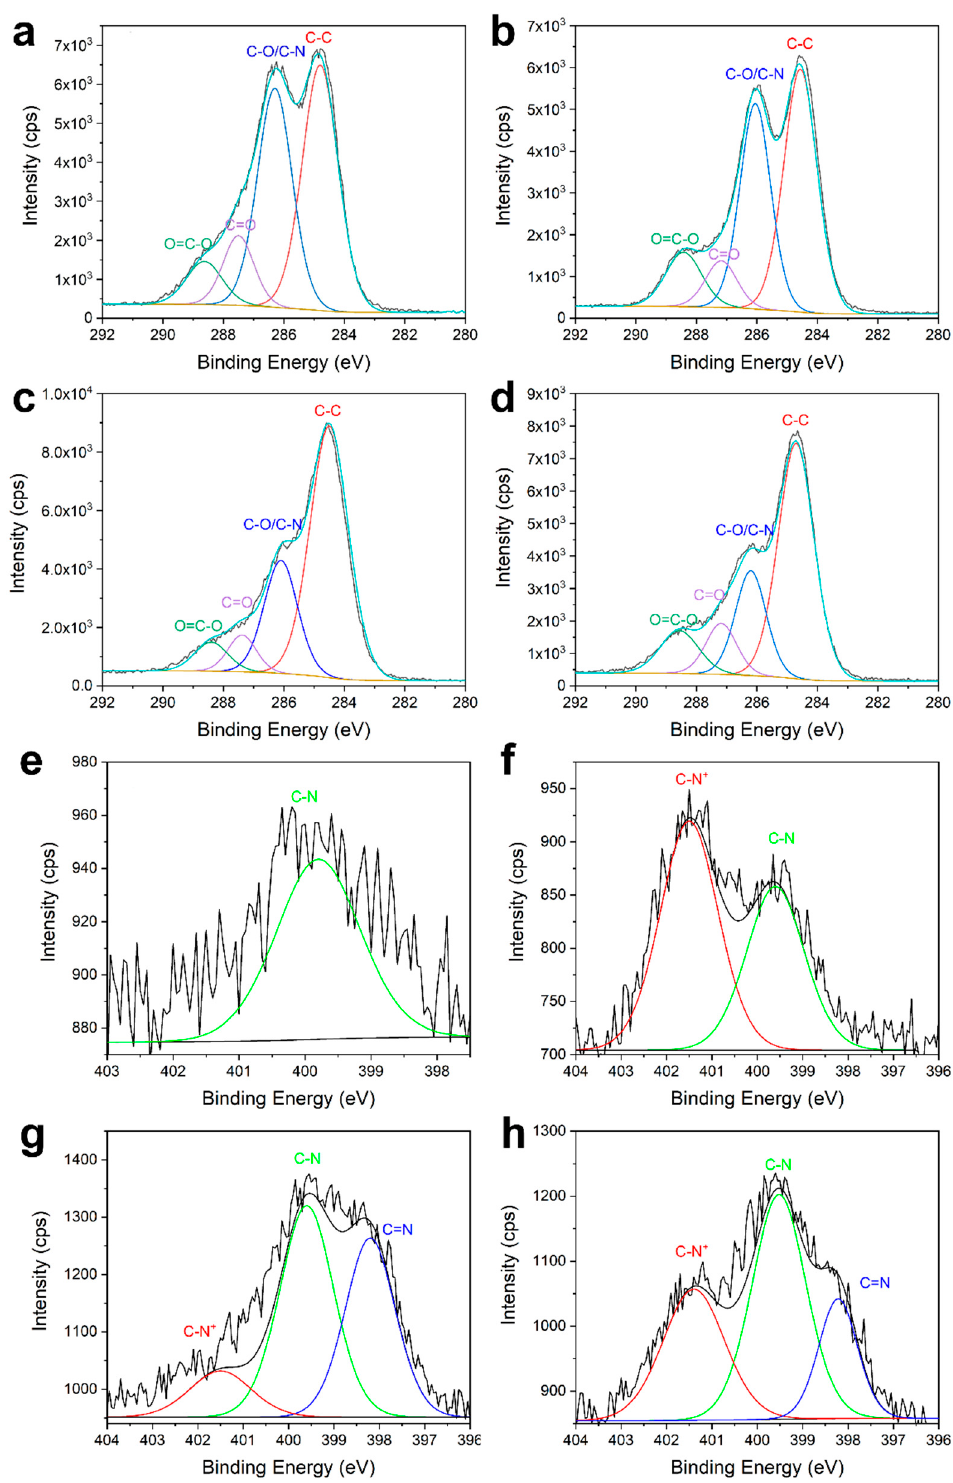
Figure 7. High-resolution C 1s spectra of the ( a ) greige fabric, ( b ) pre-treated fabric, ( c ) SCC-dyed fabric and ( d ) post-treated fabric; and high-resolution N 1s spectra of the ( e ) greige fabric, ( f ) pre-treated fabric, ( g ) SCC dyed fabric and ( h ) post-treated fabric.